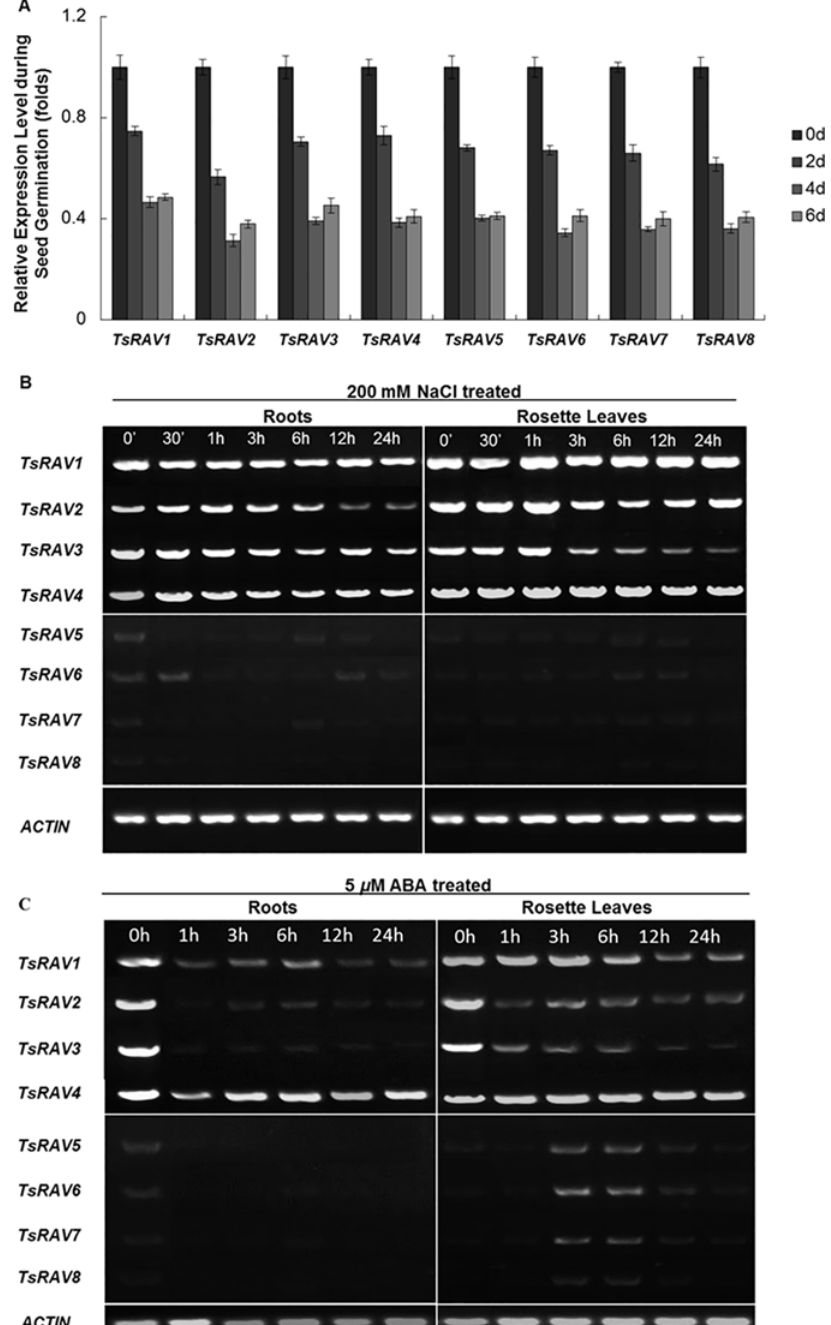
Fig 2. Expression of TsRAV genes during seed germination and in response to salt and ABA treatments. (A) qRT-PCR assay of TsRAVs transcription in Thellungiella salsuginea during seed germination. Analyses were performed on seeds at 0, 2, 4, and 6 DAI (days after imbibition). The transcription levels of genes were quantified relative to that of actin . Each data bar represents the means ± SE (Standard Error) of three replicates. (B) Semi-quantitative RT-PCR assay of TsRAVs transcription in Thellungiella salsuginea seedlings upon 200 mM NaCl treatment. Total RNA was extracted at various time intervals from leaves and roots of 15-d-old seedlings. The cDNA samples are normalized using an actin gene as an internal control. (C) Semi-quantitative RT-PCR assay of TsRAVs transcription in Thellungiella salsuginea seedlings upon 5 μ M ABA treatment. Total RNA was extracted at various time intervals from leaves and roots of 15-d-old seedlings. The cDNA samples are normalized using an actin gene as an internal control.